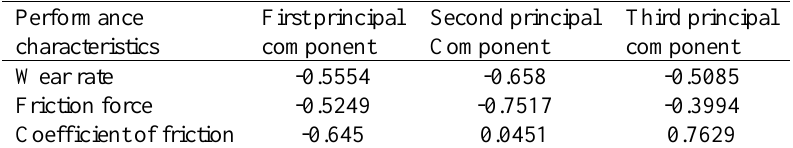
Table 7. The eigenvectors for principal components.